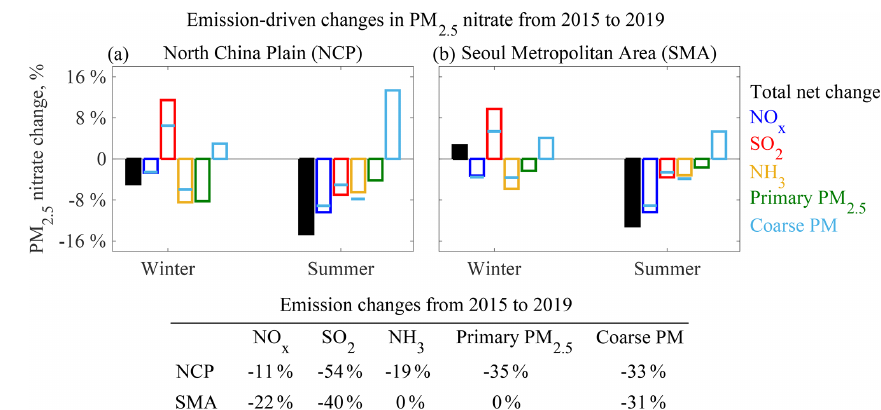
Figure 6. Emission-driven changes in mean PM 2 . 5 nitrate from 2015 to 2019 over the NCP and SMA. Results are from GEOS-Chem sensitivity simulations including total and individual emission changes over the period, all for the same meteorological year (2019) and applied both to China and South Korea (so the effects of NH 3 and primary PM 2 . 5 over the SMA are due to long-range transport from China). Values are seasonal means for winter and summer. The blue lines superimposed on the NO x , SO 2 , and NH 3 sensitivity bars show the effects from simulations not accounting for the effect of HNO 3 uptake by anthropogenic coarse